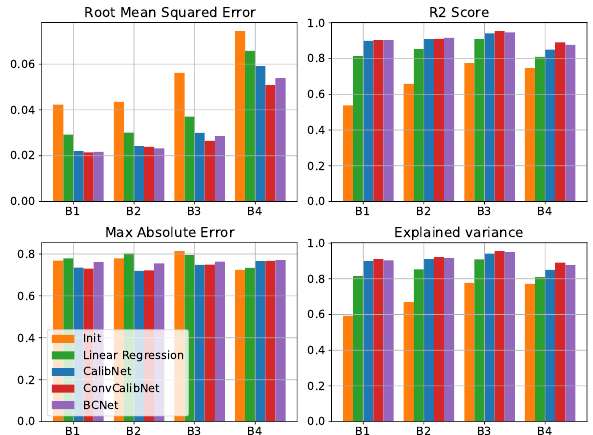
Figure 16. Comparisons of four standard metrics for the initial refletances and the four proposed methods using variance prediction, measured on Bretagne2 dataset, where the Pleiades image is contaminated by unmasked